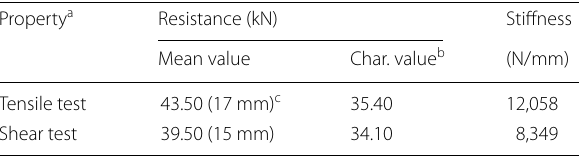
Table 3 Mechanical properties for single connector with